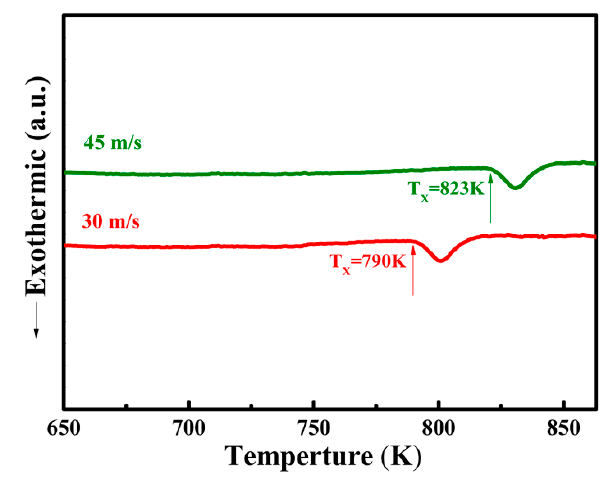
Figure 6. DSC curves of (TiZr) 0.5 (Ni 0.6 Cr 0.1 V 0.1 ) 2.1 alloy with spinning speeds of 30 m/s and 45 m/s.